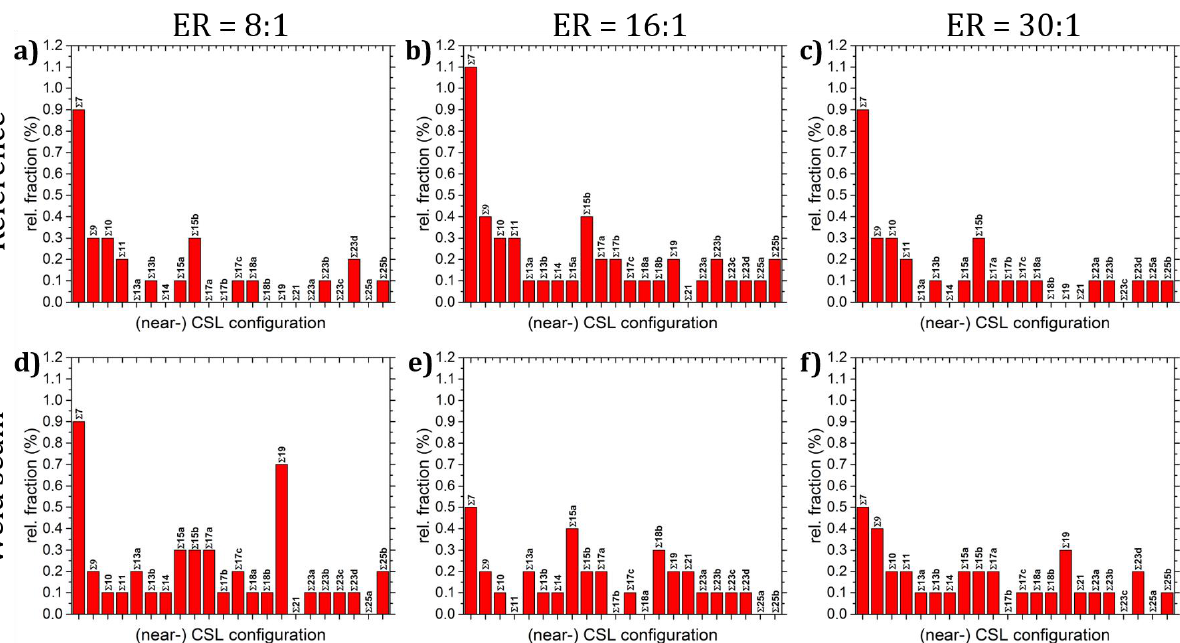
Figure 11. (near-)CSL boundaries distribution calculated from data of the above shown EBSD maps in the reference area of profiles extruded with an extrusion ratio of ( a ) ER = 8:1, ( b ) ER = 16:1, and ( c ) ER = 30:1 and the weld seam of profiles extruded with an extrusion ratio of ( d ) ER = 8:1, ( e ) ER = 16:1, and ( f ) ER = 30:1 .